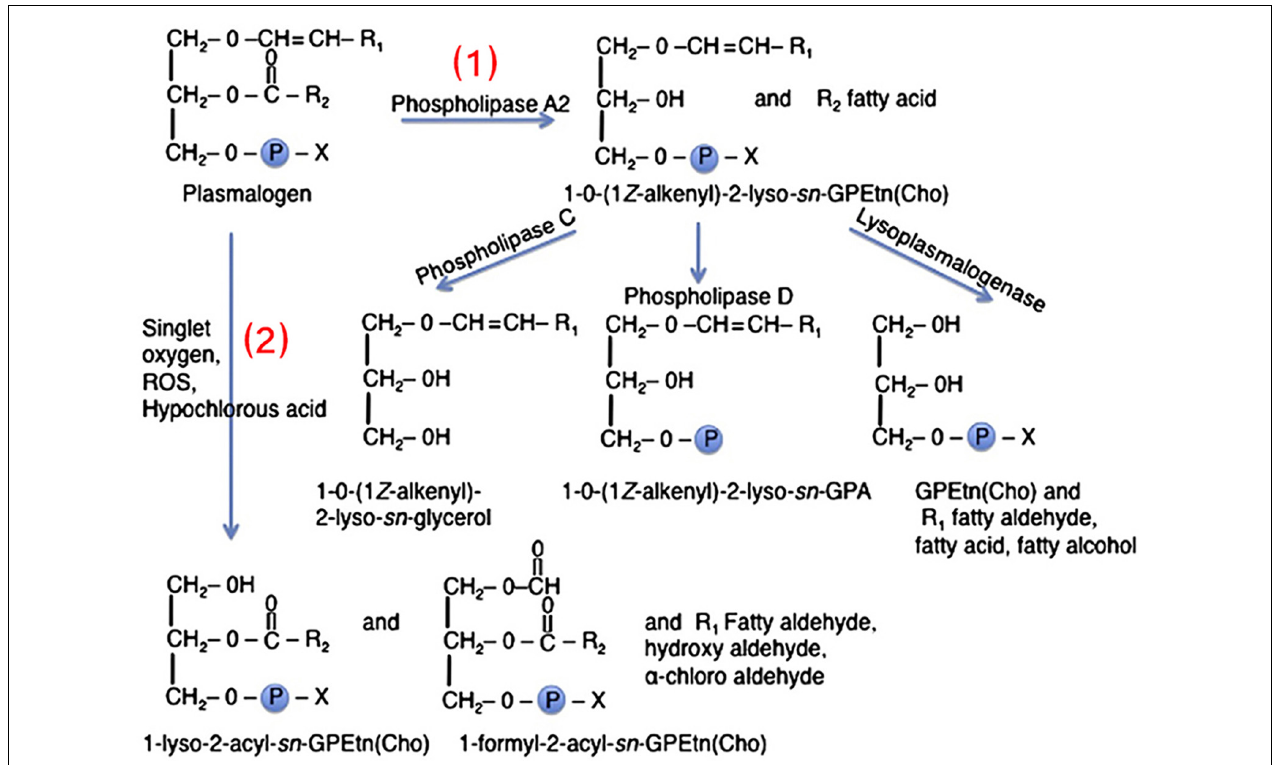
FIGURE 6 | Two pathways of plasmalogen turnover, remodeling and degradation: (1) Through phospholipase A2 (PLA2) and (2) through oxidative stress. Plasmalogens are one of the primary targets of HOCl due to sensitivity of the vinyl-ether bonds to oxidation. X denotes the polar head group, which is typically ethanolamine or choline. R1 denotes the carbon chain at the sn-1 position, and R2 at the sn-2 position. Reprinted from Braverman and Moser (2012) with